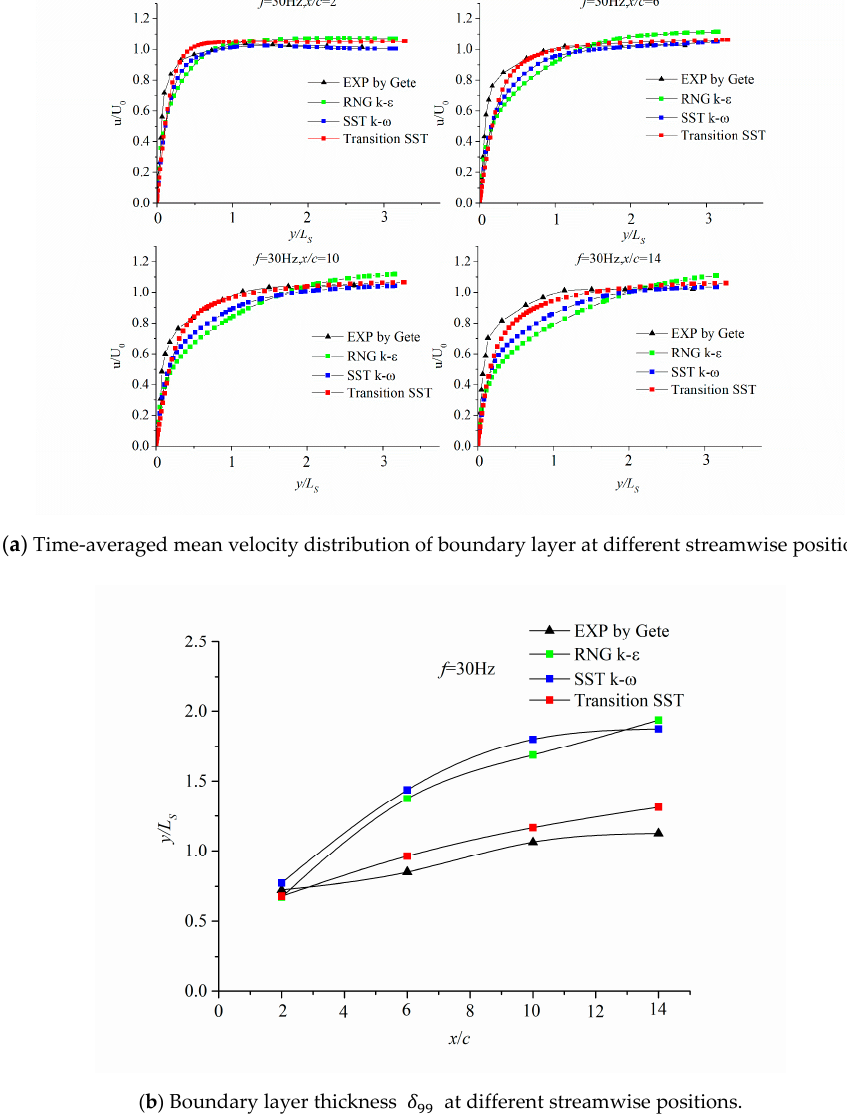
Figure 5. Comparison of boundary layer distribution between results calculated by different turbulence model and experimental results.